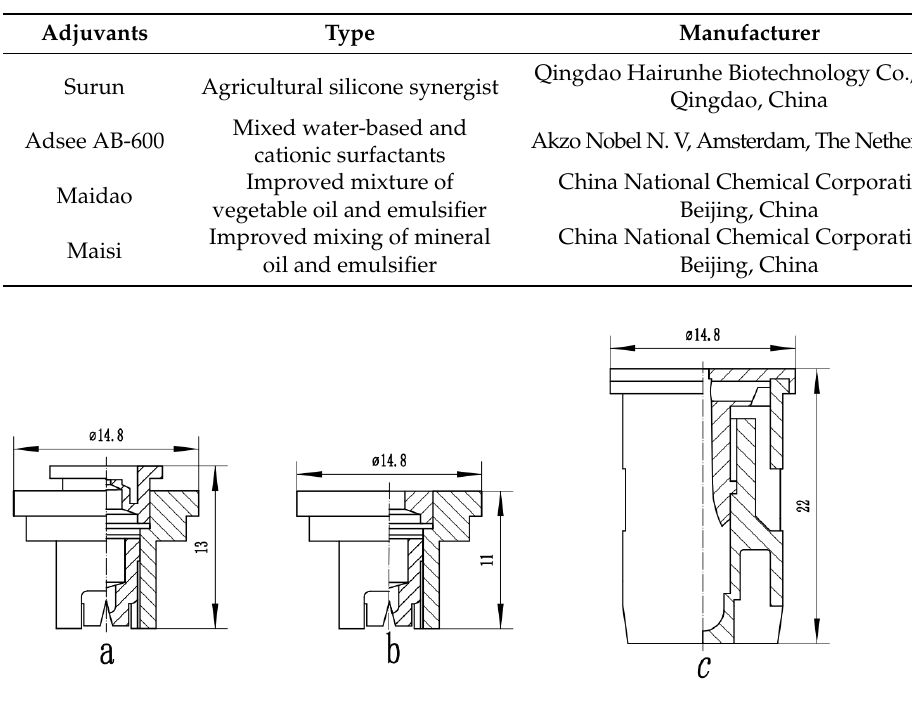
Table 1. Characteristics of different spray adjuvants.